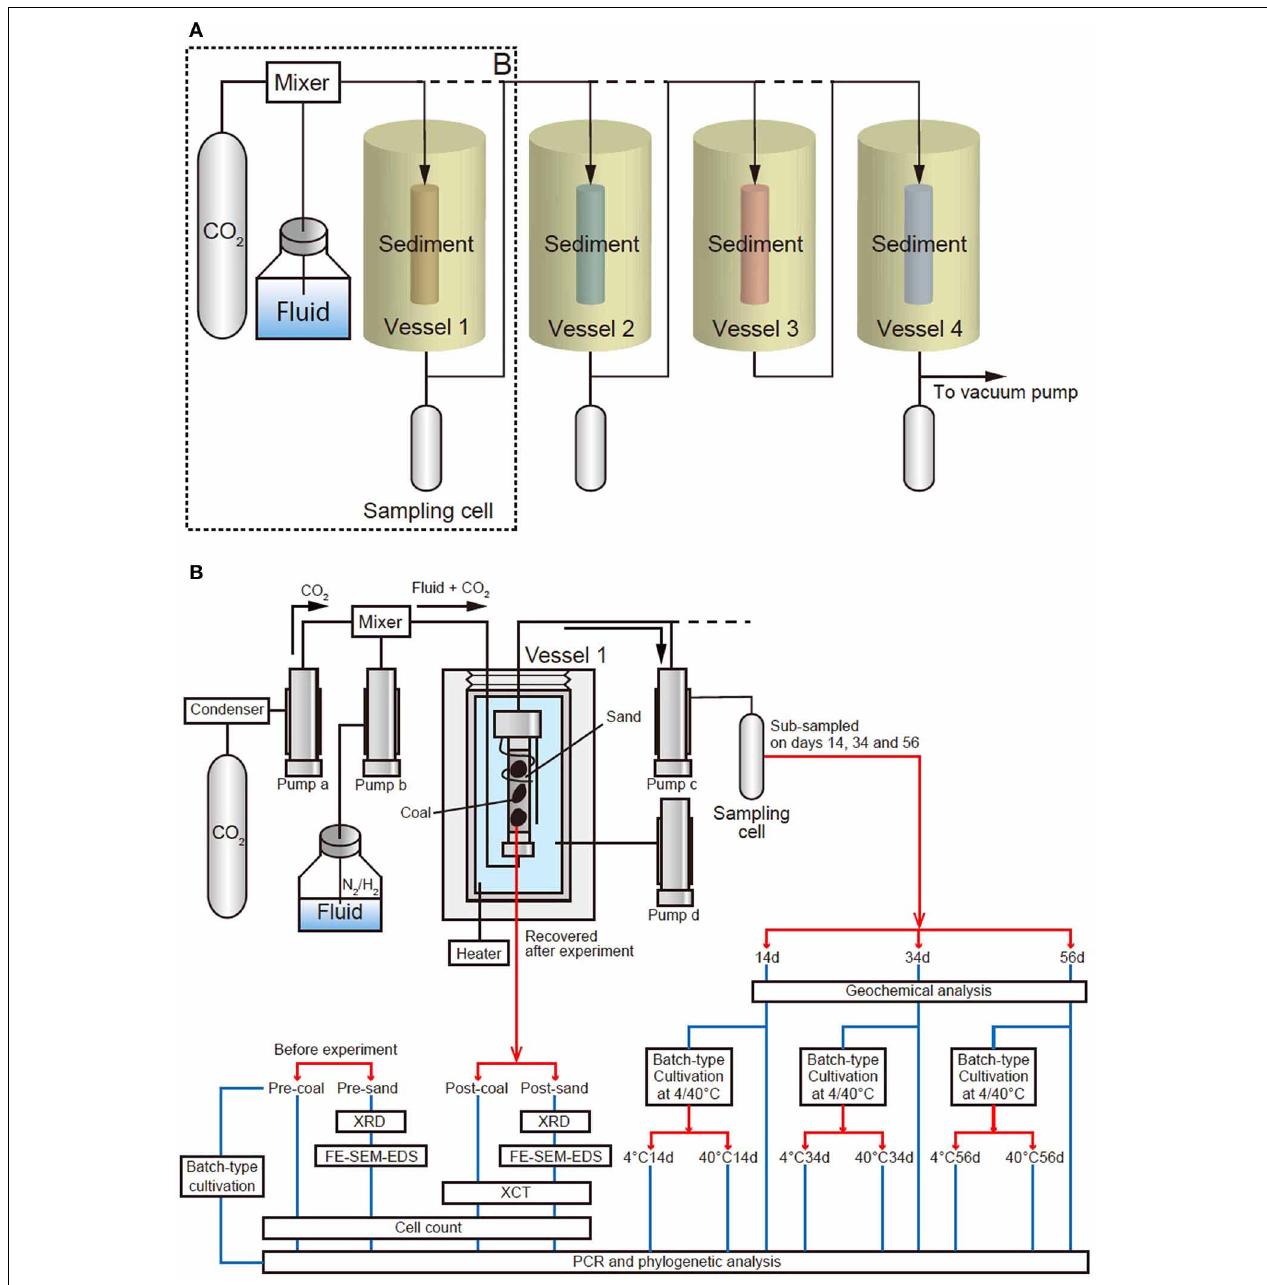
FIGURE 1 | Schematic diagram of the geobio-reactor system. The system simulates in-situ subsurface pressure and temperature conditions ranging from 0 to 100MPa and 0–70 ◦ C. (A) A schematic view of entire the reactor system, comprising four vessels and three sampling cells. CO 2 and fluid are supplemented into a maximum of four vessels through a mixer. (B) Detail of the area dashed box (‘B’) in Figure 1A . Vessel 1 is connected to two upper cylinder pumps which supply CO 2 and fluid (CO 2 : pump a, fluid: pump b). Another pump below the vessel (pump c) receives CO 2 -injected fluid that has passed through the sediment. Confined pressure is controlled by a cylinder pump d associated with the vessel filled with water (pressure medium), which is disconnected from the main